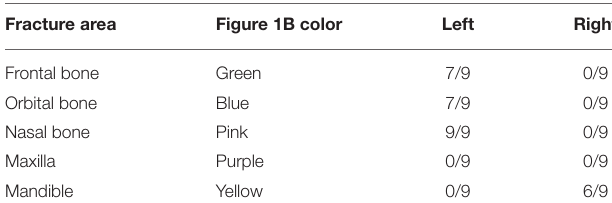
TABLE 3 | Fracture distributions for the initial (experiment 1) cohort.